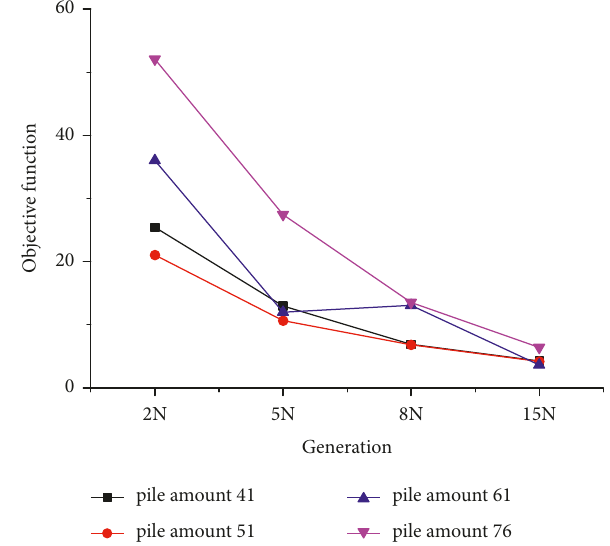
Figure 10: The influence of the genetic generation on the objective function for a fixed movable pile amount.